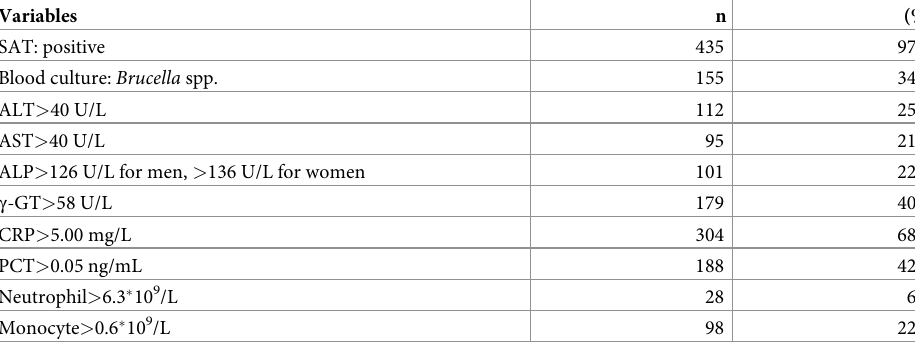
Neutrophil > 6.3 � 10 9 /L Monocyte > 0.6 � 10 9 /L SAT, serum agglutination test; ALT, alanine aminotransferase; AST, aspartate aminotransferase; ALP, alkaline phosphatase; γ -GT, glutamyl transpeptidase; CRP, C-reactive protein; PCT, procalcitonin. Variables were described as No.